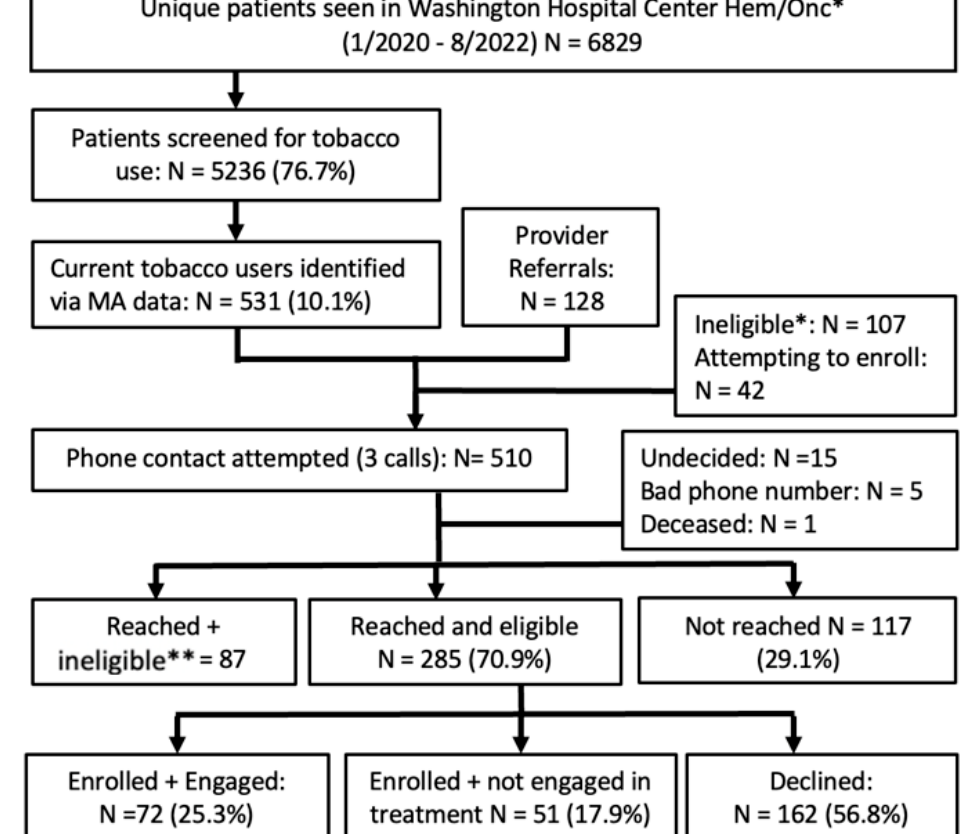
Figure 2. Washington Hospital Center workflow and recruitment. * Excluding patients who did not have a visit involving a medical assistant (3/2021–8/2022). ** Reasons for ineligibility include: too